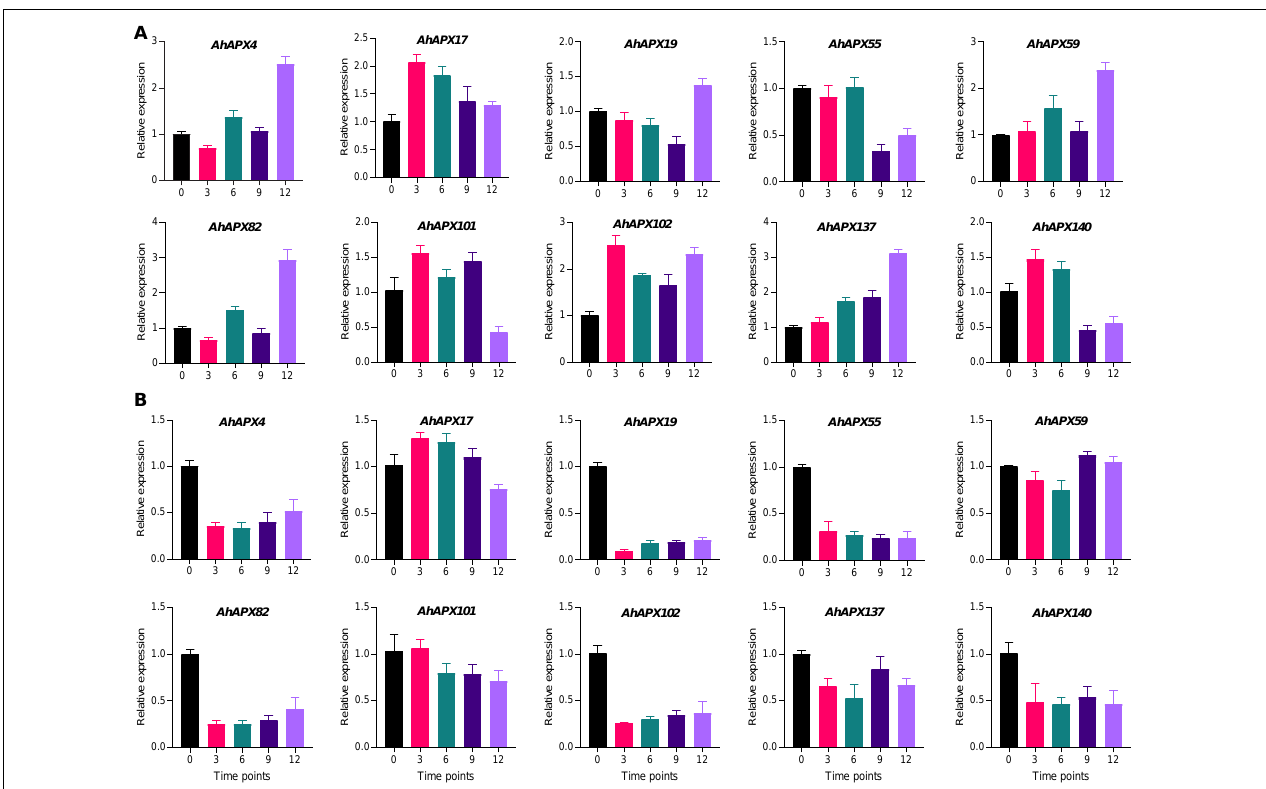
FIGURE 13 | Expression profiling of the AhAPX genes under (A) abscisic acid and (B) cold stress treatments. The time points include 0 (CK), 3, 6, 9, and 12 h when the samples were picked for expression analysis after the stress treatment. Error bars signify the SD of three biological repeats ( n = 3).